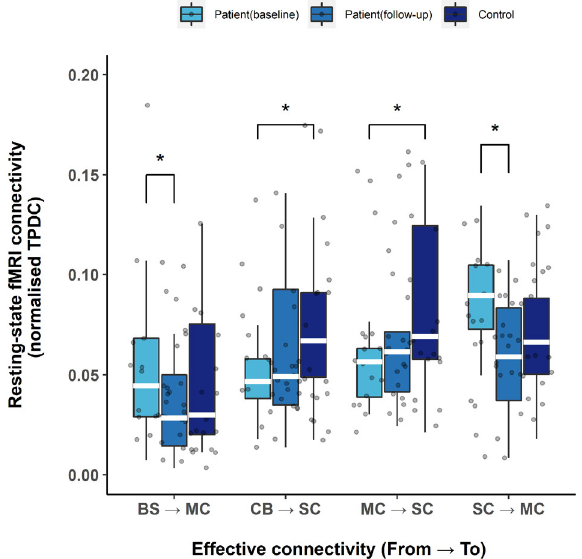
Fig. 3 Training effects on resting-state effective connectivity in Parkinson ’ s disease patients. Effective connectivity value during resting-state between the patients before and after treadmill training. The box represents lower quartile, median and upper quartile. The control group served as reference to the effects of training. BS brainstem, CB cerebellum, MC motor cortex, SC subcortical region, TPDC time-resolved partial directed coherence. * p < 0.05; white line (within the box): median